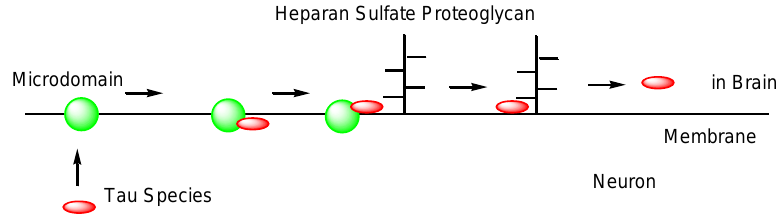
Figure 9. Tau secreted from neurons based on the endolysosomal machinery.